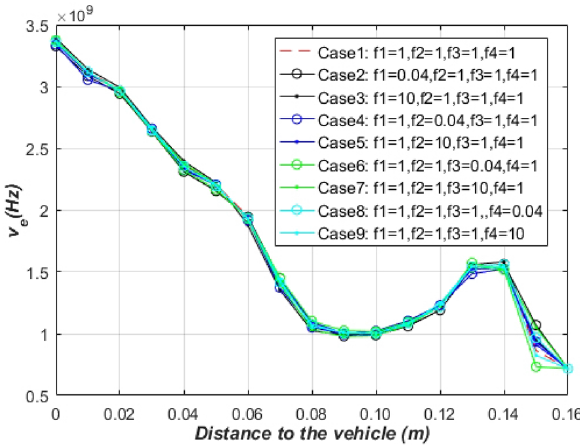
Figure 7. Influence of different non-ionization reaction rates and ionization reaction rates on the electron collision